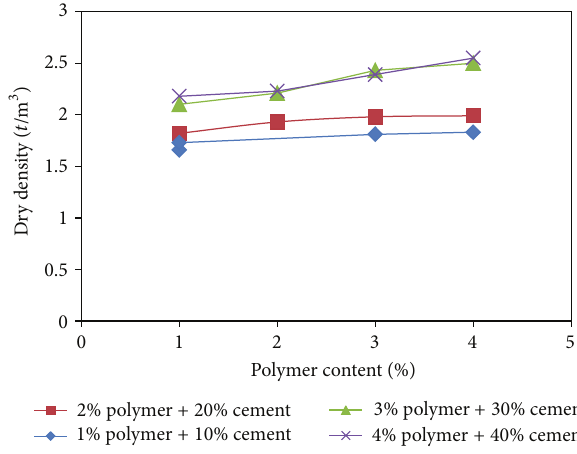
Figure 8: Effect of polymer content on maximum dry density of soil in dry conditions for 7 days.